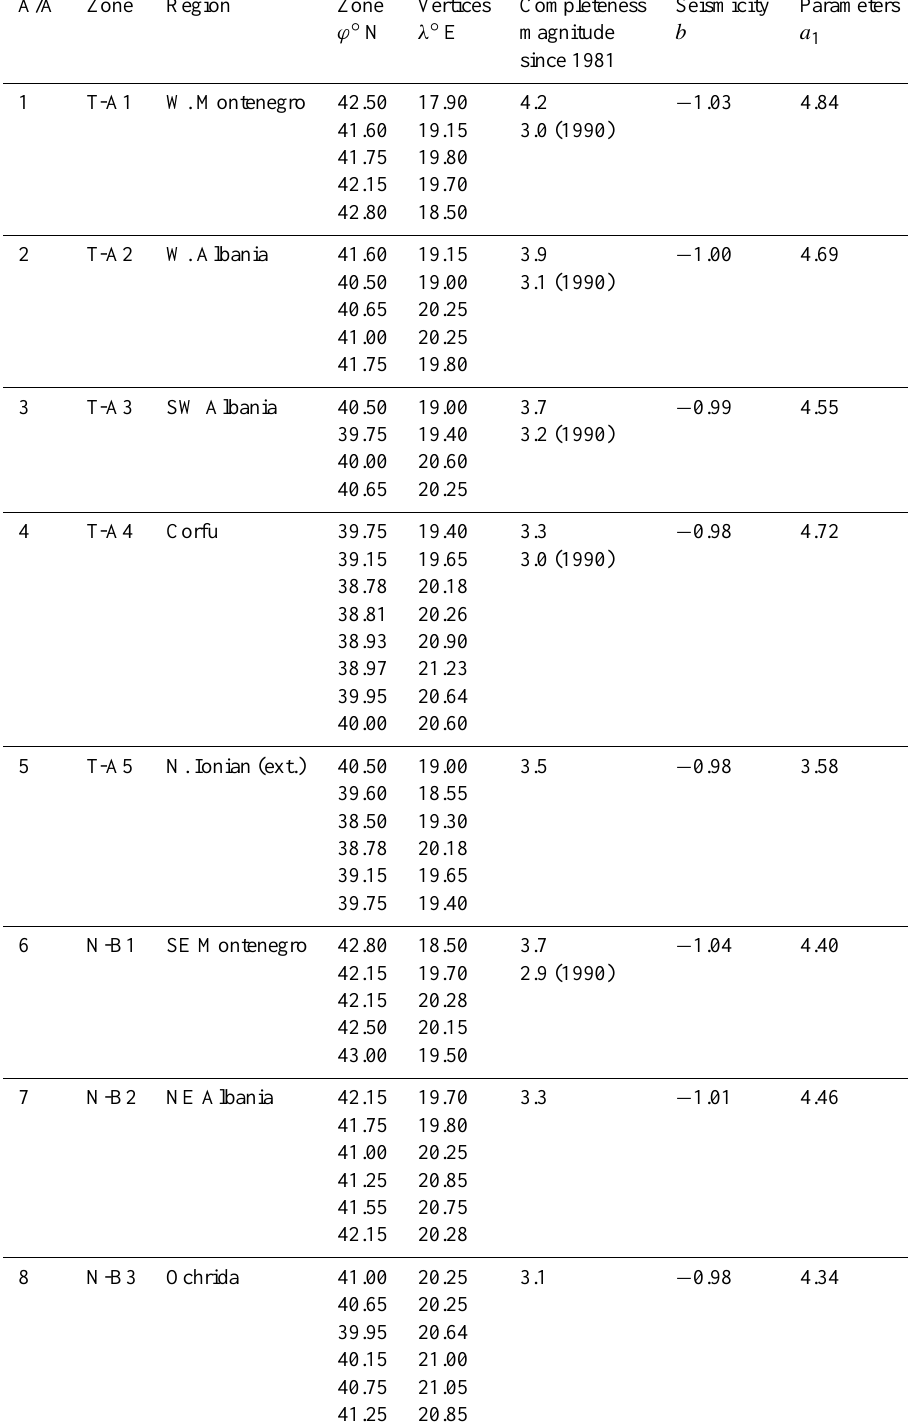
Table 1. Details for the 113 shallow zones of the proposed zonation model. Information for the completeness magnitude since 1981 (addi- tional completeness is also listed, when available) and the estimated b and a 1 (per 10000km 2 ) G–R parameters are also